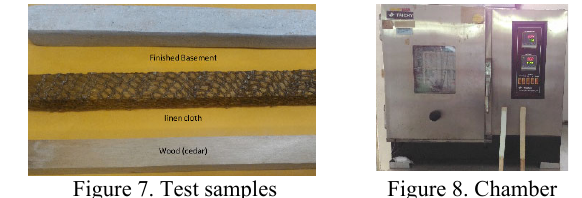
Figure 7. Test samples Figure 8.